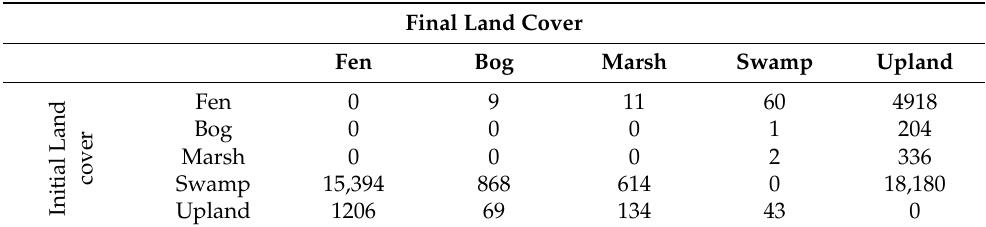
Table 8. Matrix showing the assignments using the proposed ensemble classifier in comparison with Classifier #1 (the traditional method) for all pixels with changes in class assignment. Columns are the land covers that a misclassified pixel was first assigned to from Classifier #1. The rows correspond to the land cover that a pixel was assigned to by the ensemble classifier.